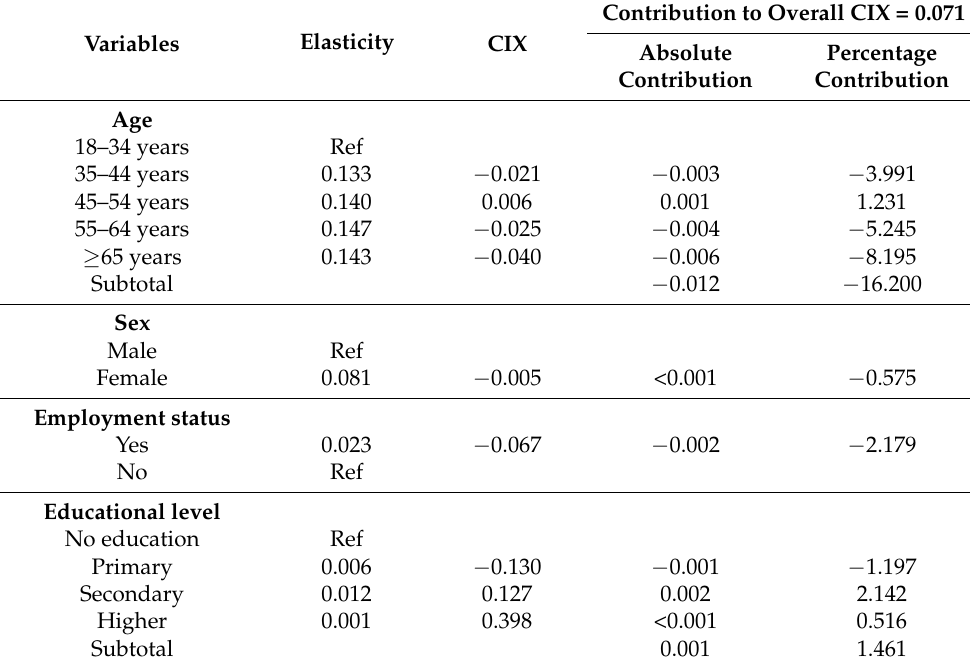
Table 4. Decomposition of inequality measurement of diabetes.